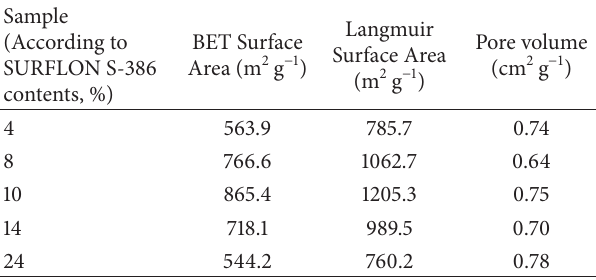
Table 1: The parameters of the porous texture of the synthesized MFSs.